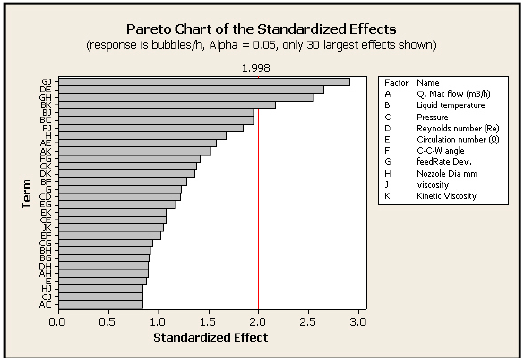
Figure 6. Liquid bubble significant factors.